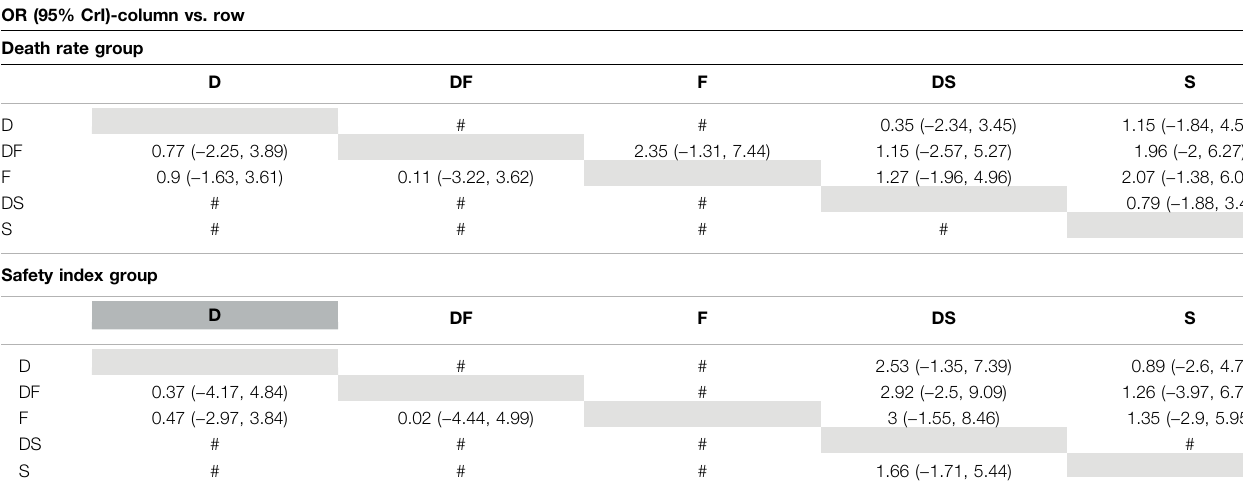
All network meta-analysis comparisons are represented in table but only Digoxin as baseline in forest plot ( Figure 3 ). As shown in Table 2 , no signi fi cant difference existed in death rate group,butSappearedtobemoresafethoughlessef fi cacious.Afterconsideringbotheffectivenessandsafetyinthesafetyindexgroup,nosigni fi cantdifferenceswereobservedinall fi ve regimens. OR,oddsratio;CrI,credibleinterval;D,digoxinmonotherapy;DF,digoxinand fl ecainidecombinationtherapy;DS,digoxinandsotalolcombinationtherapy;F, fl ecainidemonotherapy;S, sotalol monotherapy; SVT, supraventricular tachycardia; AF, atrial fl